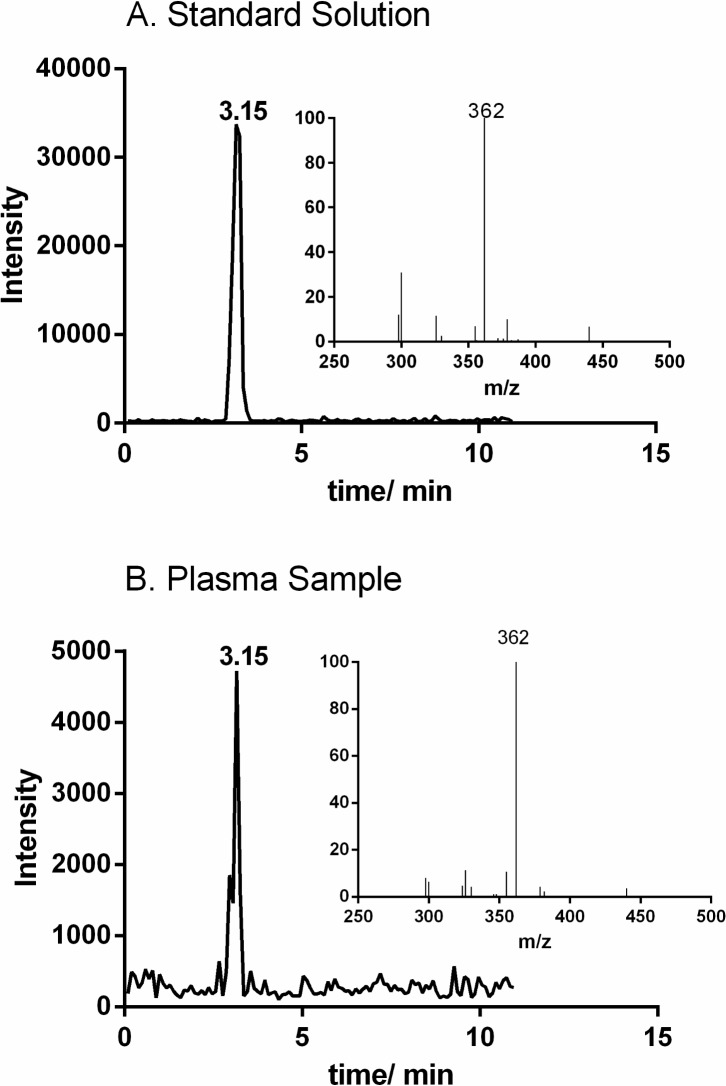
MRM chromatograms of (A) NAGLy in a standard solution (136 pg on column) and (B) a representative plasma sample together with corresponding MS spectra (inserts).